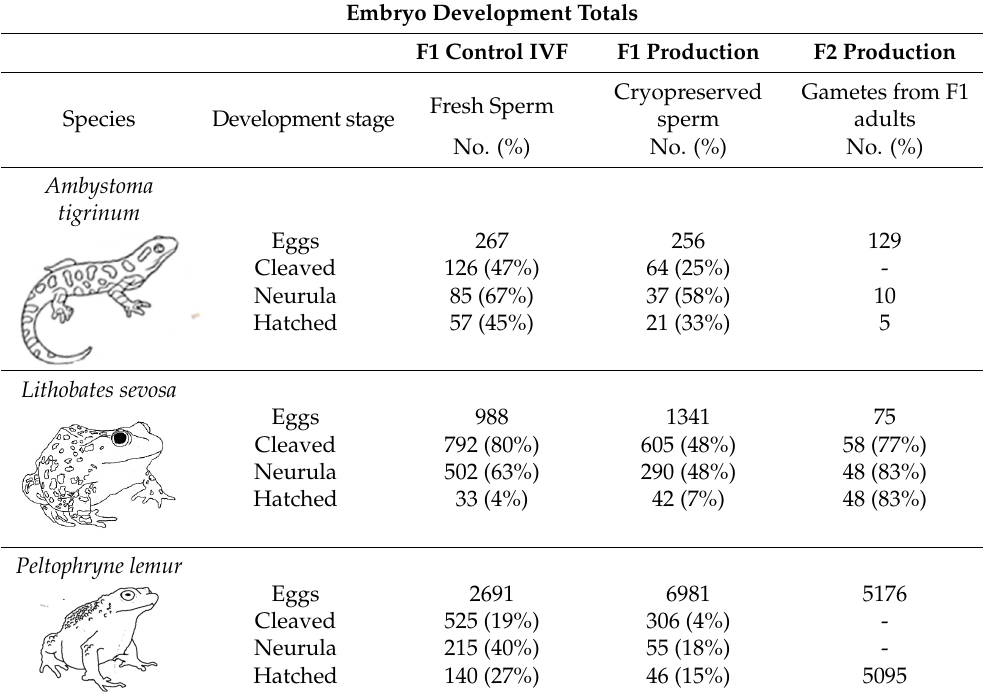
cent of cleaved eggs, neurulas, and hatched tadpoles for each species are shown in Table 1 and represent the production of the F1 generation of animals. Table 1. Summary table of cleaved embryo and larvae/tadpole development totals for the F1 and F2 generations produced through cryopreservation and in vitro fertilization. Eggs numbers for each species represent one male and female pairing. Cleaved embryos are shown as a percentage of eggs used, whereas neurula and hatch rates are shown as a percentage of cleaved embryos. Missing values for A. tigrinum and P. lemur cleavage rates were due to challenges associated with access to zoo or academic buildings overnight. Embryo Development